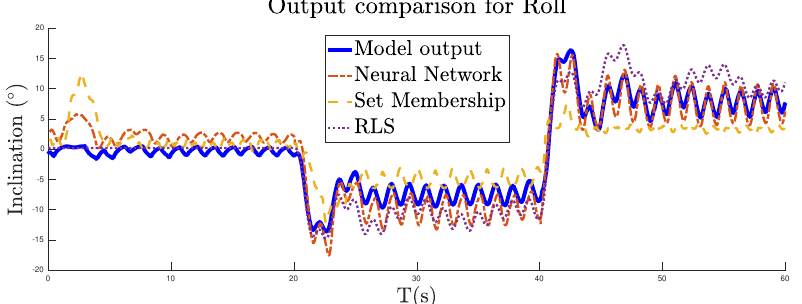
Figure 23. Prediction configuration results for roll in Test